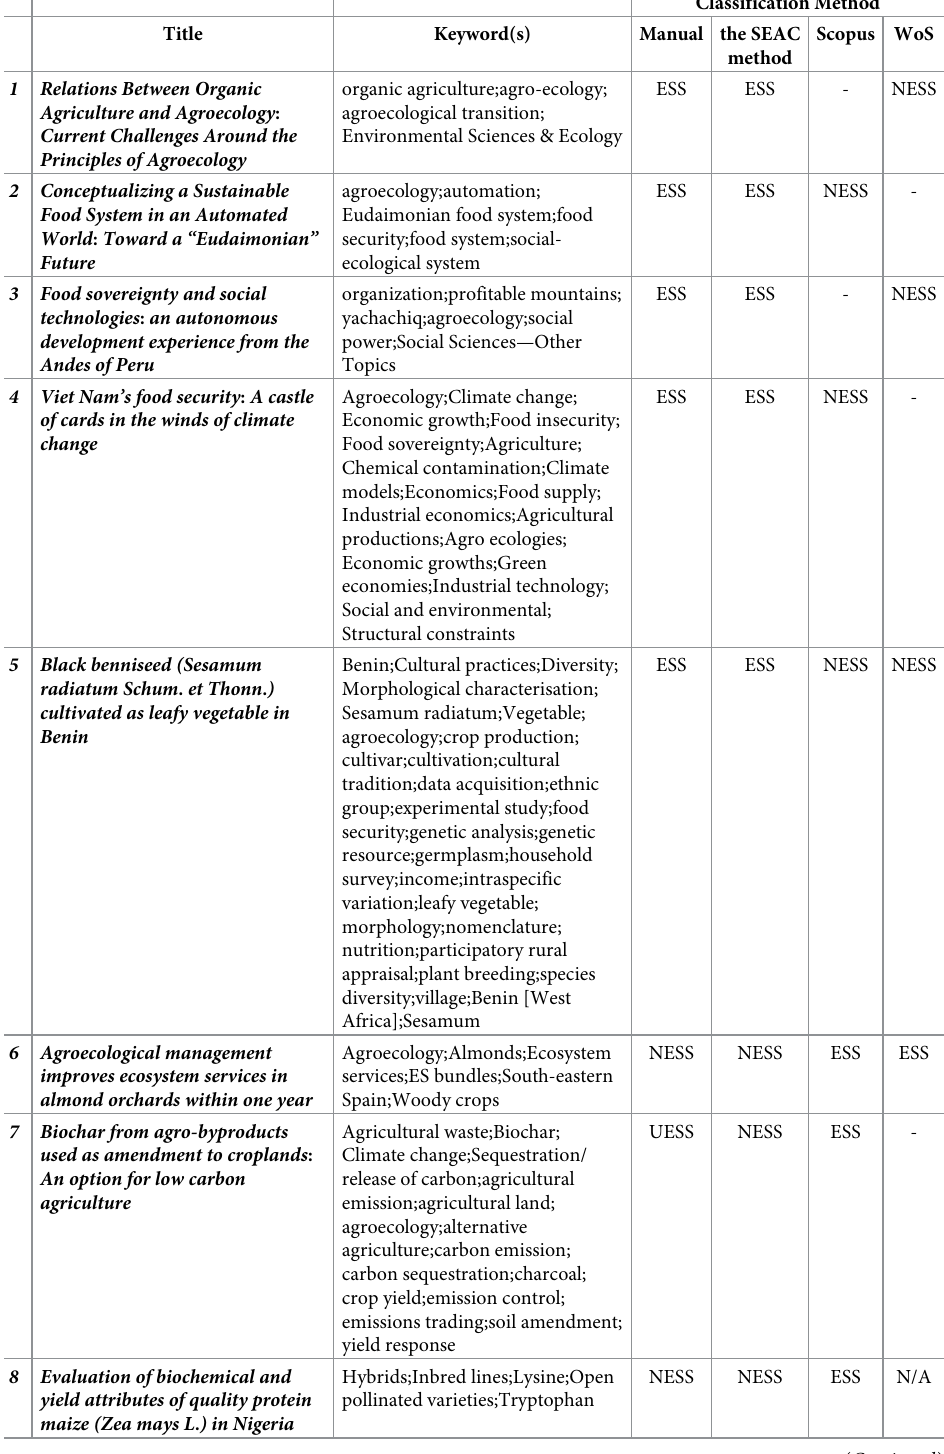
Table 10. Validating the SEAC method with a random set of disagreeing